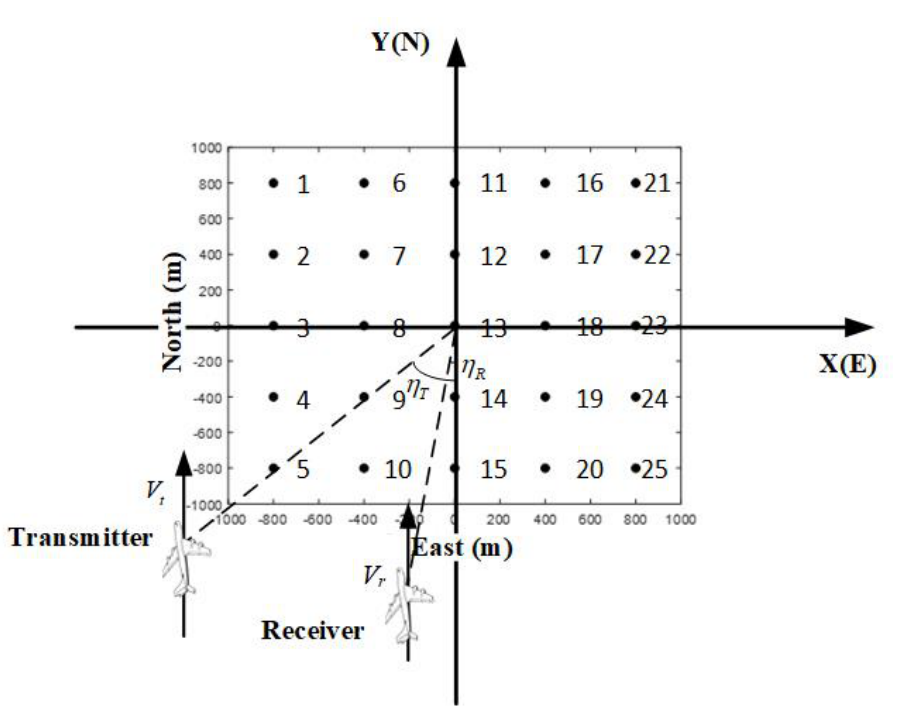
Figure 7. The targets of the simulation experiment and the bistatic configuration. In the simulation experiment, the high-frequency error parameters are directly given; they are shown in Table